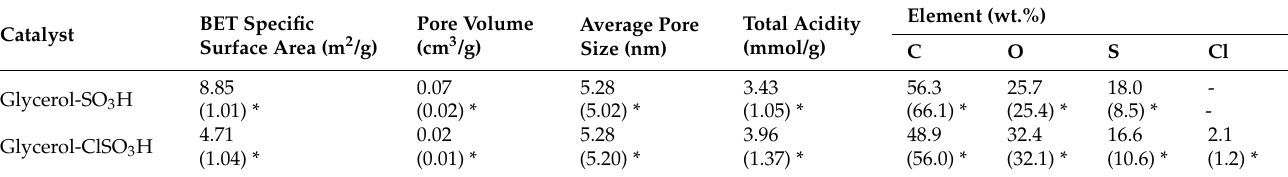
Figure 2. NH 3 -TPD absorption curves of acidic catalyst, glycerol-SO 3 H and glycerol-ClSO 3 H. Table 1. Textural properties, elemental compositions, and total acidity of acidic glycerol